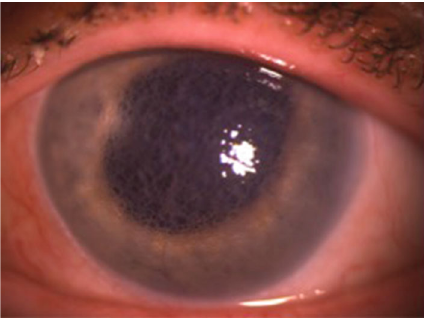
Figure 1: Slit lamp photograph of the left eye with di ff use